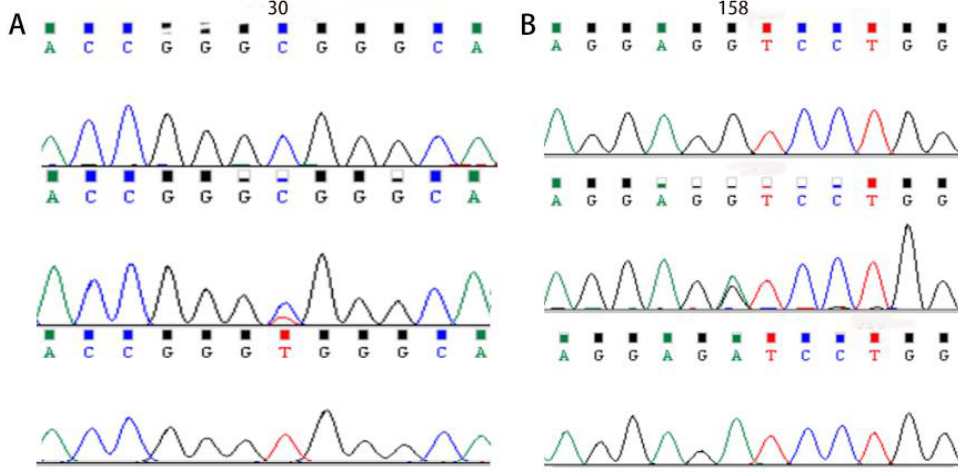
Figure 3. Sequencing peak map of two mutation sites in MYOZ1 . ( A ) Sequencing peak map of the mutation site at 30 bp. ( B ) Sequencing peak map of the mutation site at 158 bp.